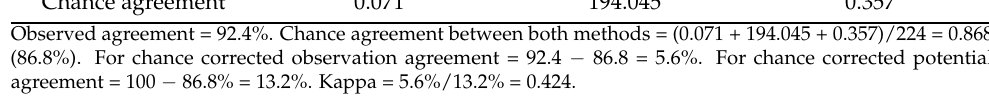
Table 2. Calculation for Cohen’s kappa based on Table 2. Range CHA 2 DS 2 -VASc score 0–10. CHA 2 DS 2 -VASc score